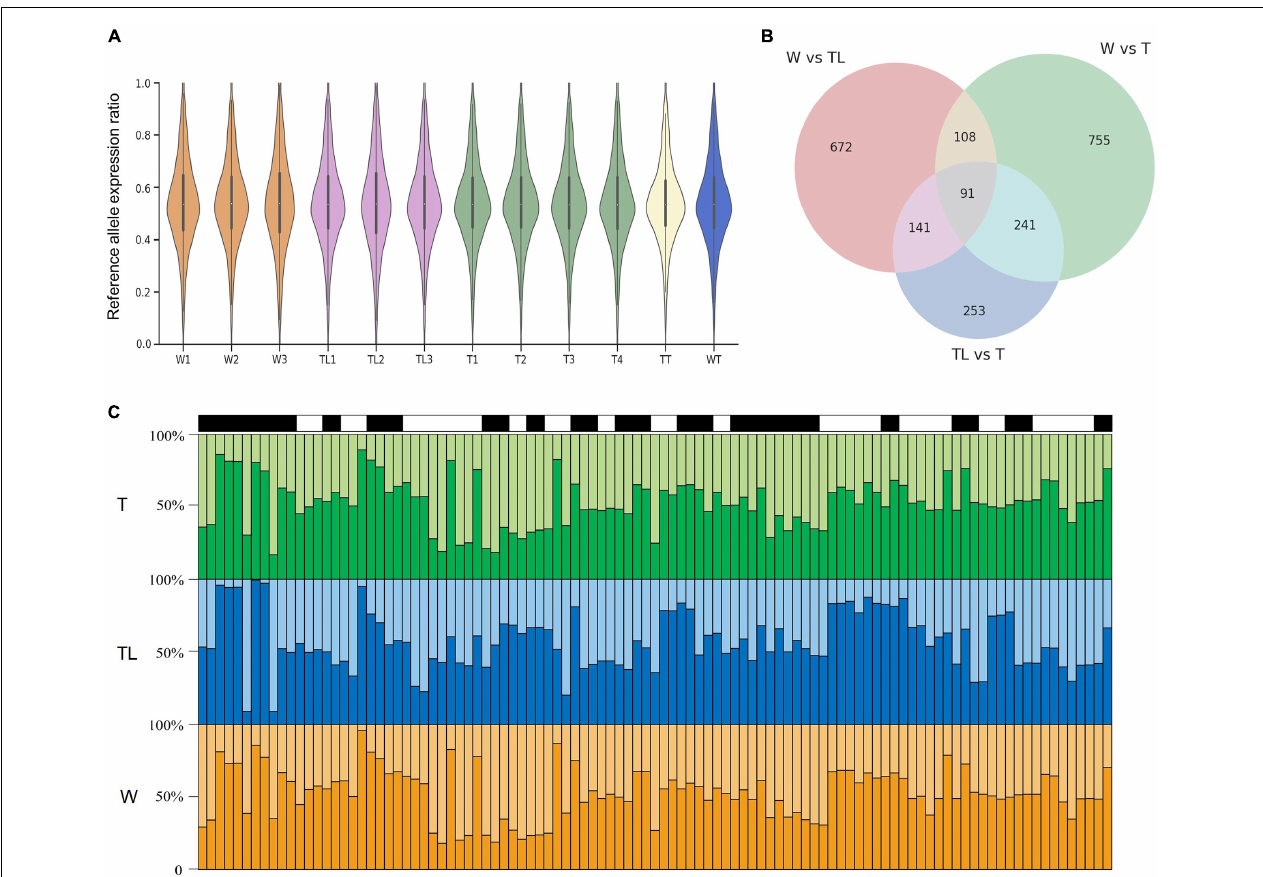
FIGURE 6 | Allelic expression difference (AED) in the pummelo genotypes. (A) Reference allelic expression ratio distribution on heterozygous exonic SNVs in the 12 transcriptomes. (B) Number of SNVs with significant AED in W, TL, and T and their overlapping relationship. (C) Allelic expression ratio on 25 genes in which significant AED was observed between TL and both W and T. Each of the black and white rectangle represents a gene on top of the three panels, and each bin in the bar graphs represents an SNV. The vertical axis denotes the allelic expression ratio. Reference allelic expression and alternative allelic expression are represented by dark and light colors in the three